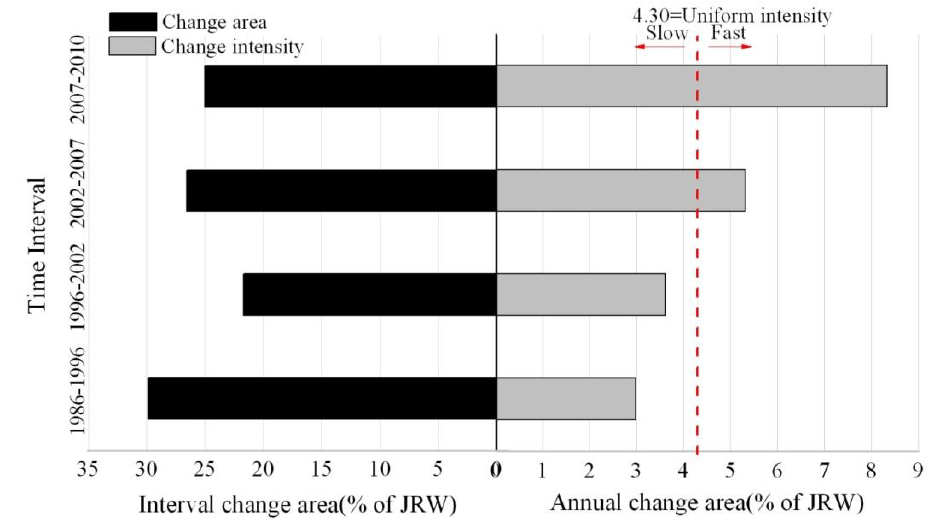
Figure 7. Interval level intensity analysis across four time